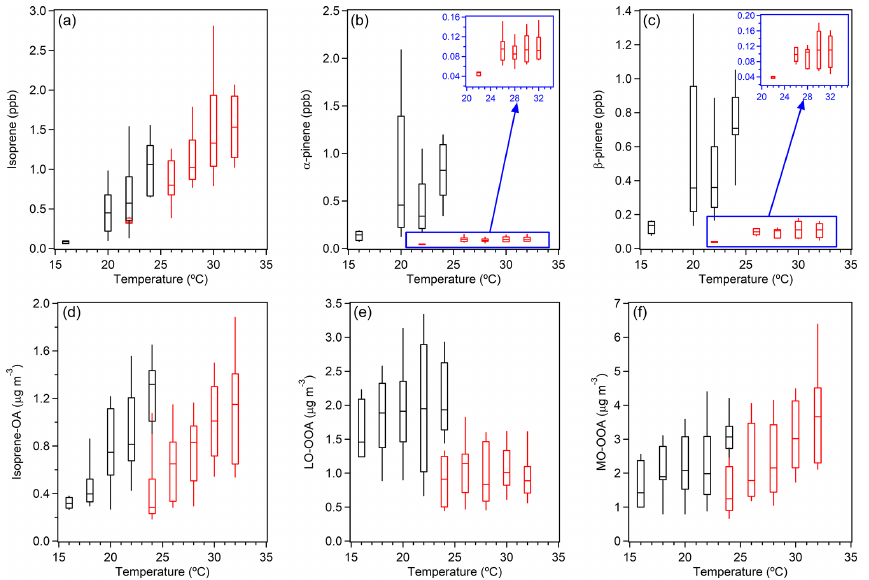
Figure 8. Main biogenic VOC mixing ratios (a, b, c) and AMS OA factor mass concentrations (d, e, f) as a function of temperature. The data points are grouped into different temperature bins with a 2 ◦ C increment and colored by time of day; afternoon (12:00–16:00EDT) measurements are in red, and night (00:00–04:00EDT) measurements are in black. The midpoint line, lower and upper boxes, and lower and upper whiskers represent the median and the 25th, 75th, 10th, and 90th percentiles,